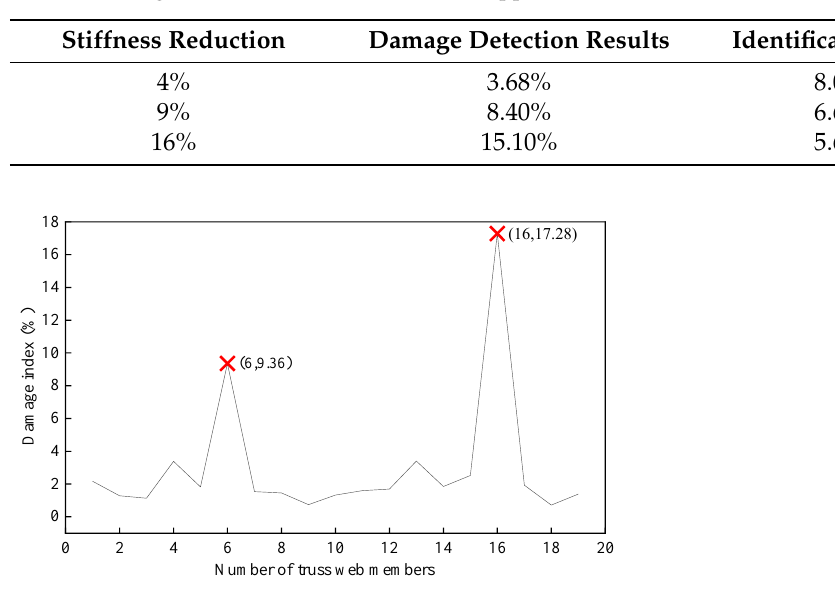
Figure 12. Results of multi-point damage detection under static loading.